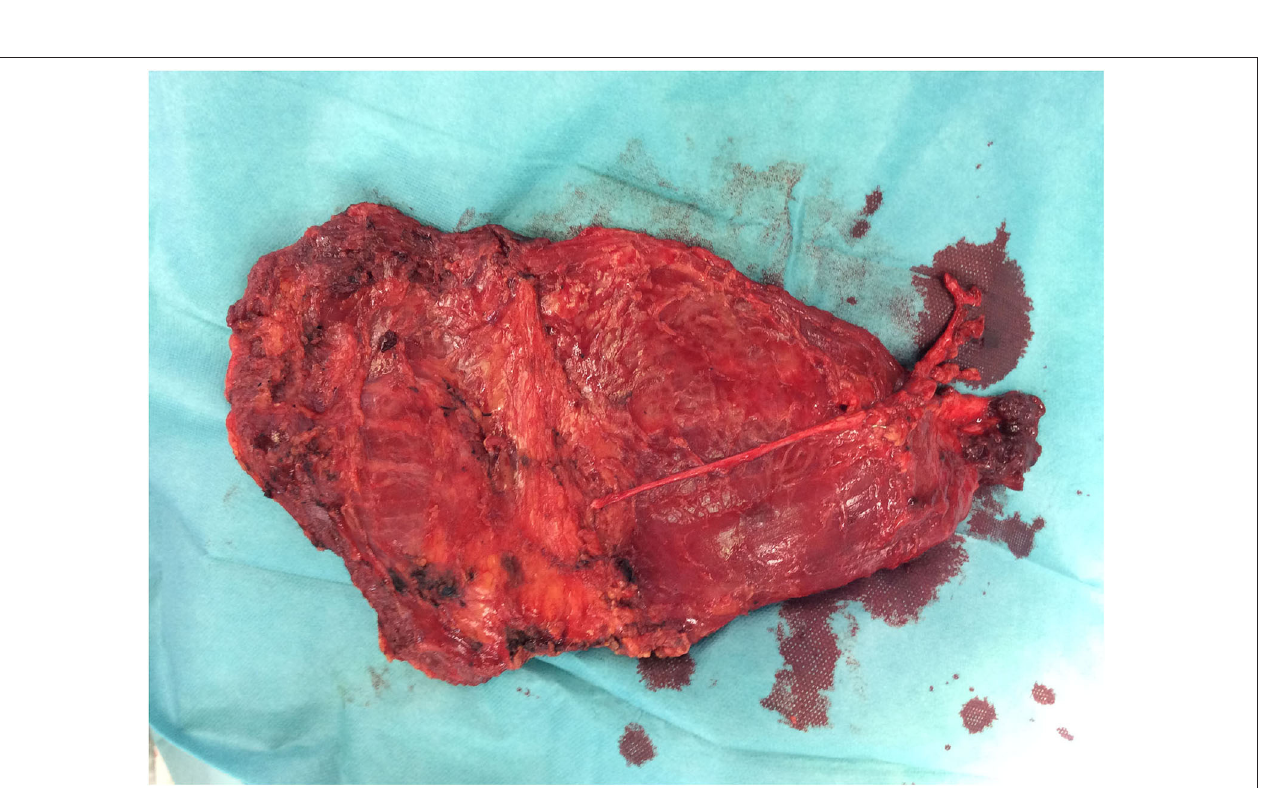
FIGURE 4 | LDM free flap, with long thoracodorsal nerve, prepared for transfer in abdominal region.